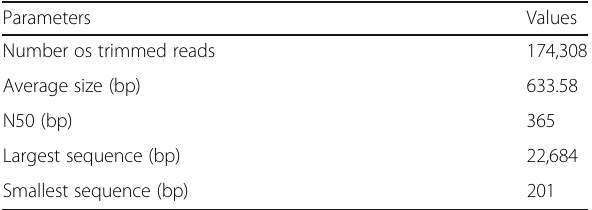
Table 1 Statistical analysis of the transcriptome sequencing and de novo assembling with